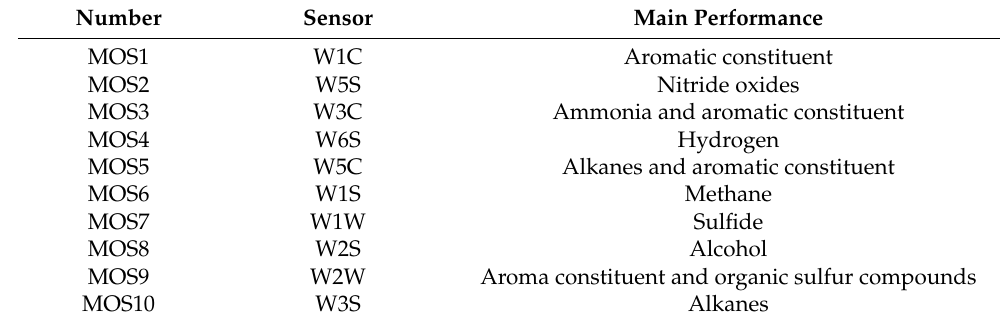
Table 3. Standard sensor array of the PEN3 E-nose